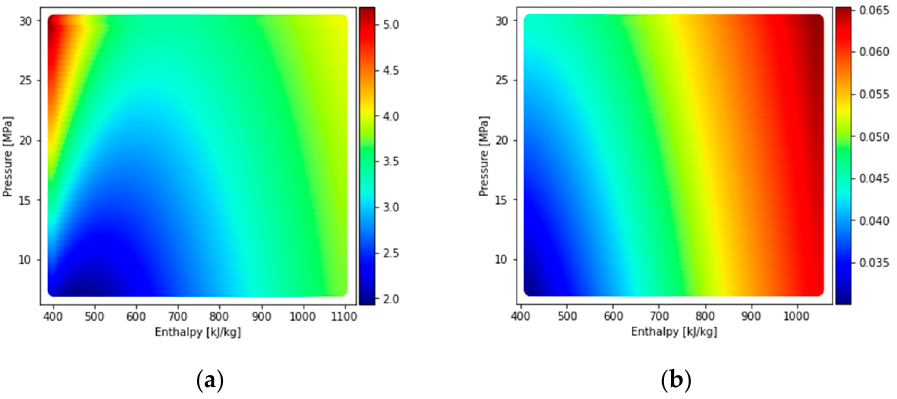
Figure 3. ( a ) Viscosity of carbon dioxide as a function of enthalpy and pressure; ( b ) Thermal conductivity of air as a function of enthalpy and pressure.